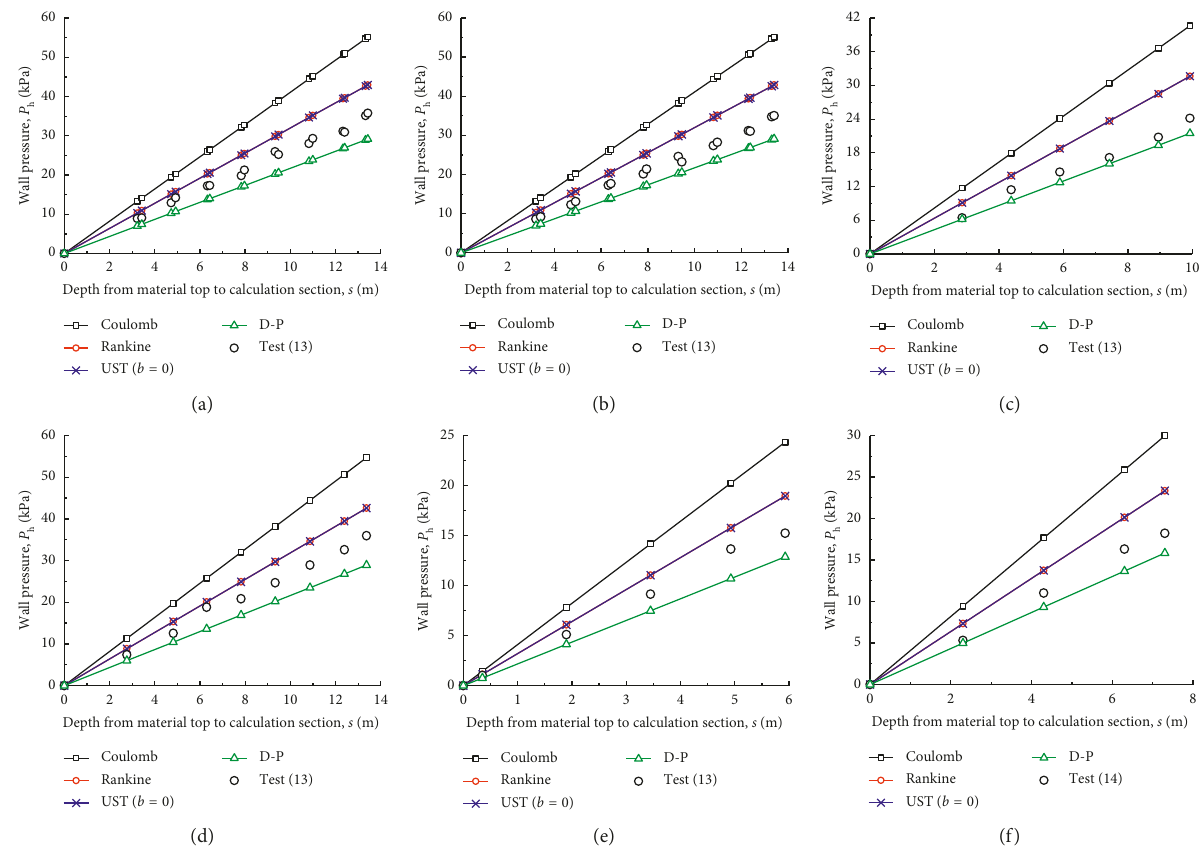
Figure 6: Comparisons of the results from two theories and two strength criteria with experimental data for squat silos (modified from Sun et al. [37]). (a) Experimental data of No. 4 silo for the first group from Yuan [13] (cone pile). (b) Experimental data of No. 4 silo for the second group from Yuan [13] (flat pile). (c) Experimental data of No. 7 silo for the first group from Yuan [13] (cone pile). (d) Experimental data of No. 7 silo for the second group from Yuan [13] (flat pile). (e) Experimental data of No. 8 silo for the first group from Yuan [13] (flat pile). (f) Experimental data of No. 4 silo for the first group from Chen [14] (cone